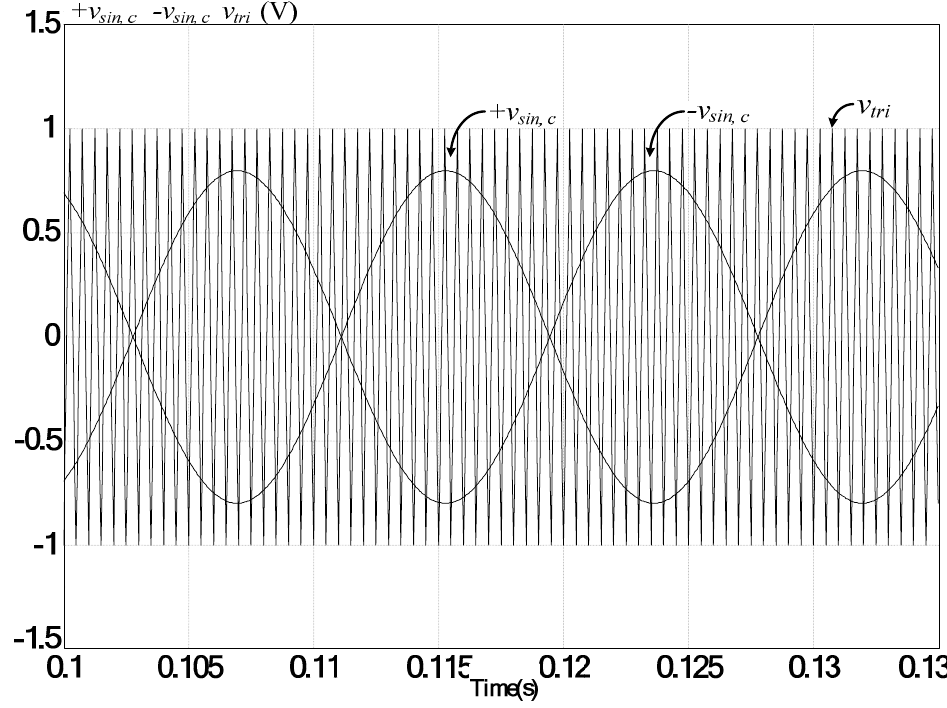
Figure 16. The PWM control signal waveforms for the case of inverter switch S c 2 + with an open-circuit fault.